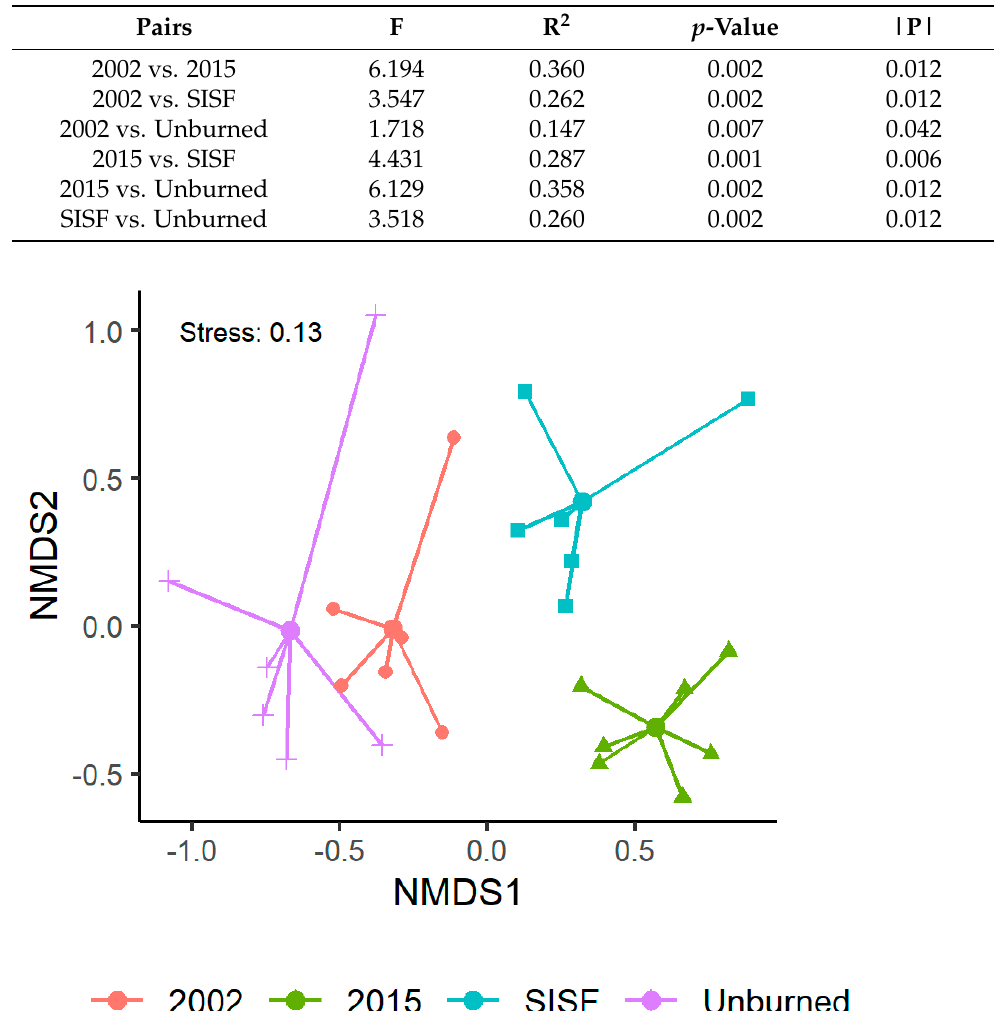
Table 2. Pairwise comparison of assemblage compositions between sampling locations. PER- MANOVA tests are df 3, 21 = 4.19, p -value < 0.01.